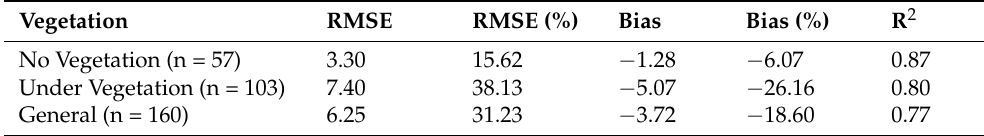
Figure 6. Digital terrain models (DTMs) obtained with DAP-UAV data. Table 5. Statistics of the comparison between the altitude of the DTM generated by photogrammetry and the altitude of the terrain control points obtained by RTK in areas under vegetation (Present) and in areas without vegetation (Absent).